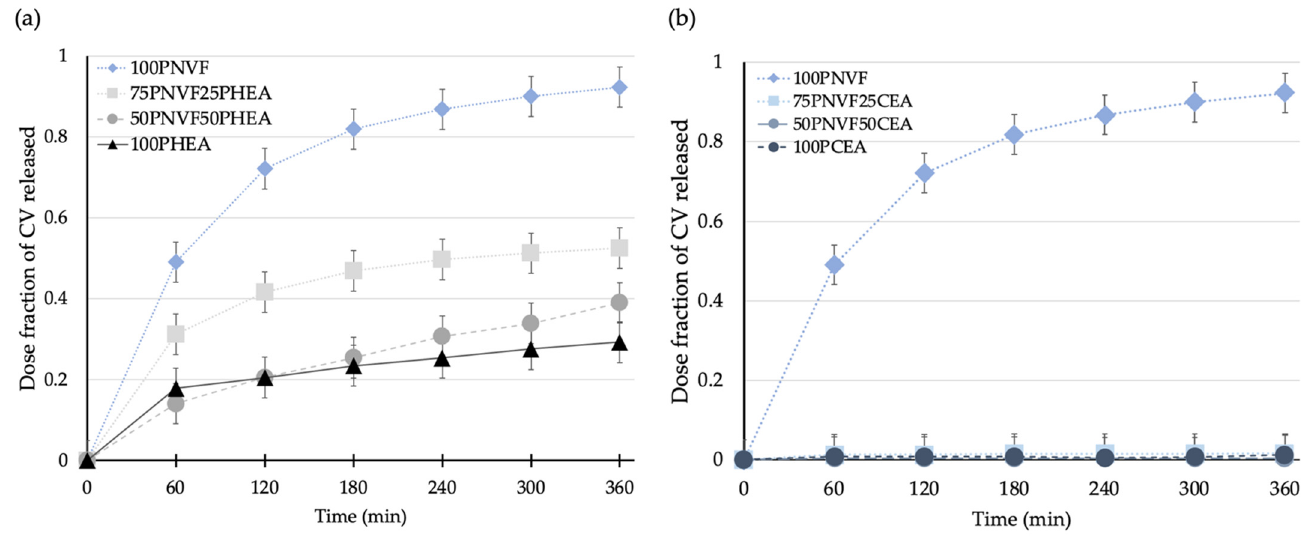
Figure 7. Release profiles of ( a ) P(NVF-co-HEA) hydrogel series and ( b ) P(NVF-co-CEA) hydrogel series with 0.0001 M crystal violet solution.